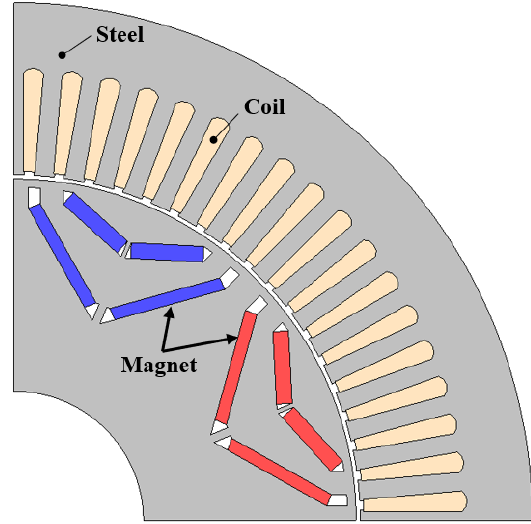
Figure 9. Configuration of the reference model.